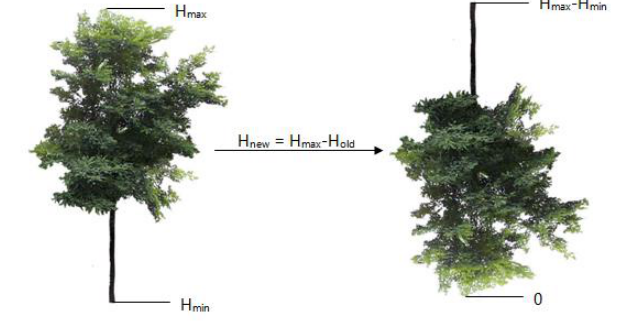
Figure 3. Height reversal process